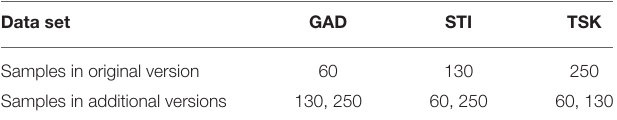
TABLE 2 | Main parameters of the pollen data